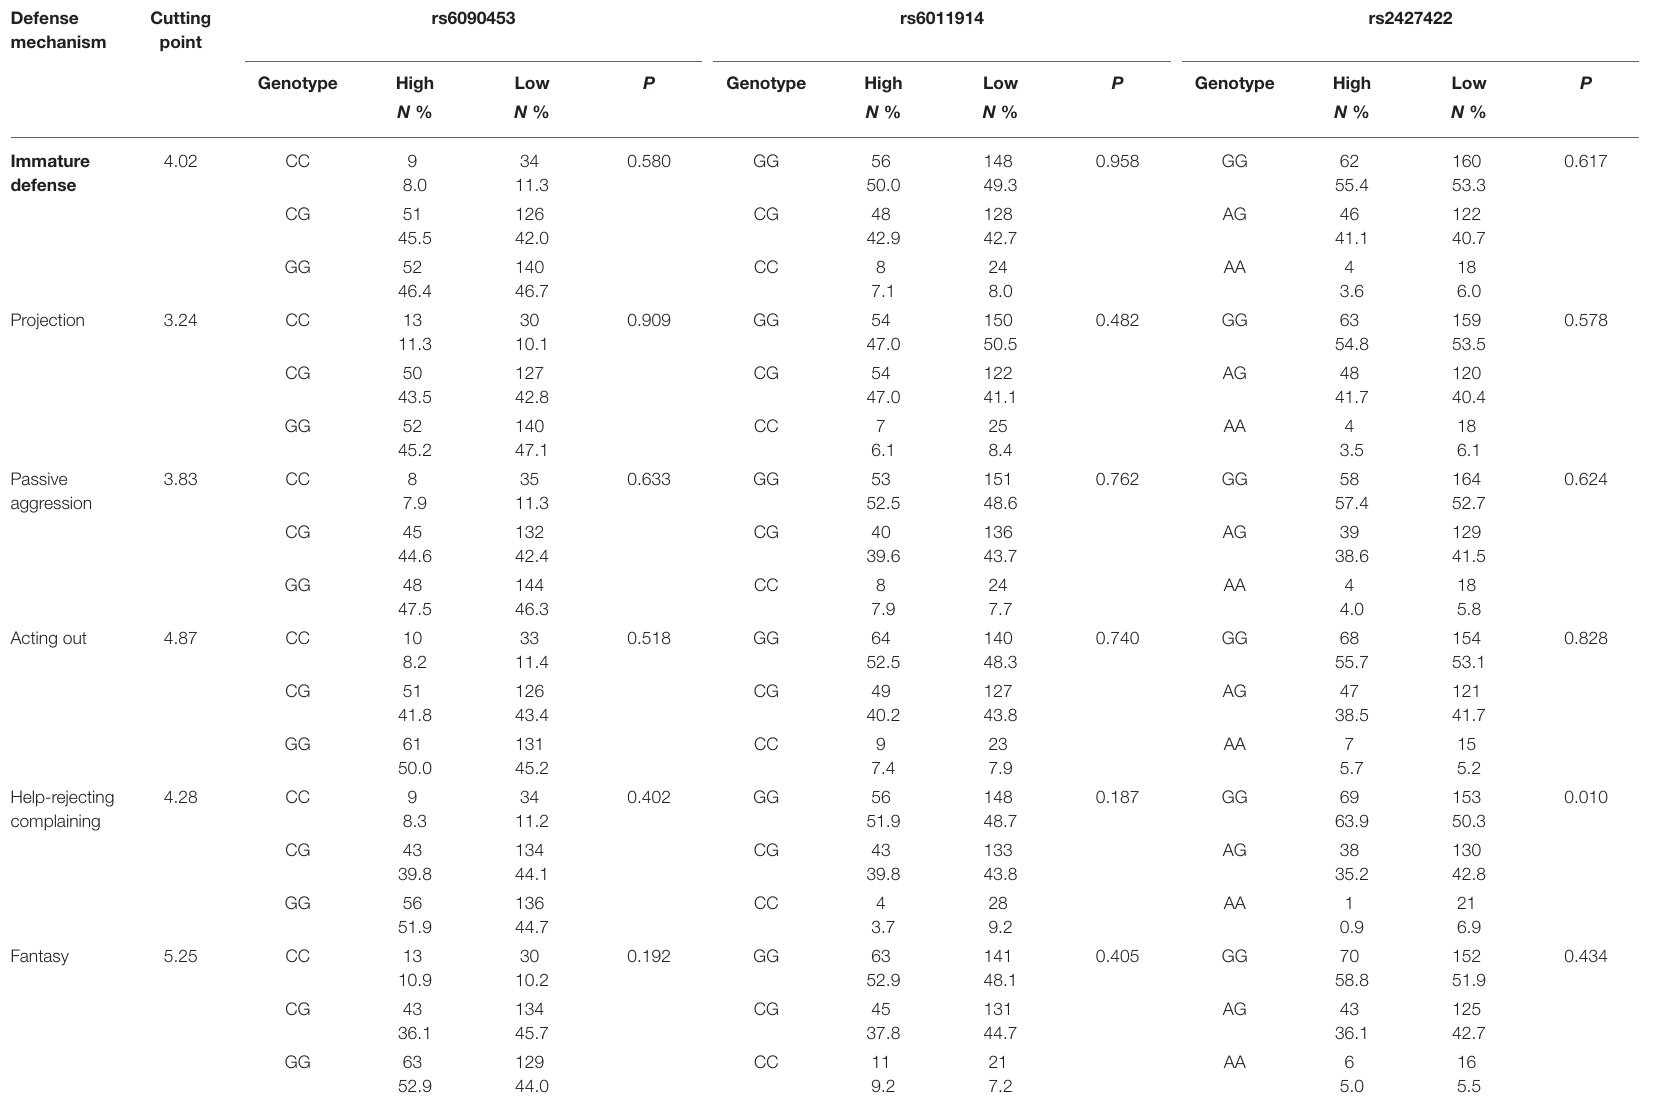
TABLE 5 | Comparison of genotype distributions of NTR1 gene polymorphisms between high- and low-score subgroups. Defense